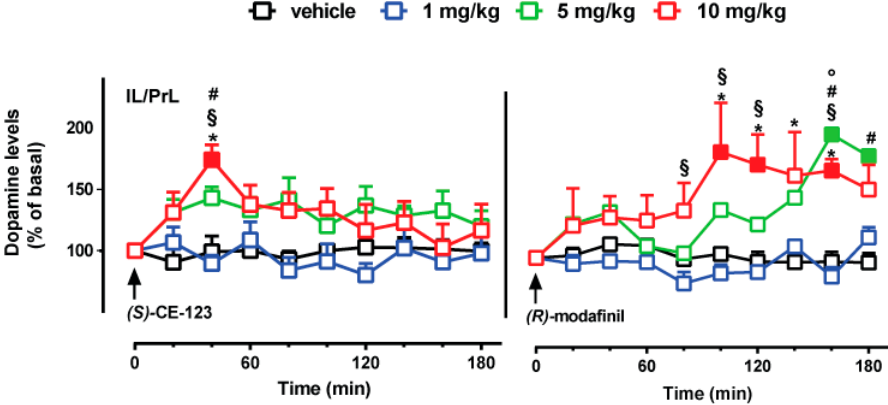
Figure 3. Effect of ( S )-CE-123 and R- modafinil on dopamine transmission in the IL/PrL cortex. Graphs showing the effects of ( S )-CE-123 (left) or R- modafinil (right) on dopamine levels in the IL/PrL cortex. The arrow indicates i.p. injection of ( S )-CE-123 or R- modafinil at the dose of 1 mg/kg (blue), 5 mg/kg (green), 10 mg/kg (red) or vehicle (black). Results are presented as mean ± SEM of change in dopamine extracellular levels expressed as the percentage of basal values. Solid symbol: p < 0.05 with respect to basal values; * p < 0.05 ( S )-CE-123 10 mg/kg vs. vehicle; § p < 0.05 ( S )-CE-123 10 mg/kg vs. ( S )-CE-123 1 mg/kg dose; # p < 0.05 ( S )-CE-123 5 mg/kg vs. veh; ° p < 0.05 R -modafinil 10 mg/kg vs. ( S )-CE-123 10 mg/kg (( S )-CE-123 n = 21; R- modafinil n = 12). Three-way ANOVA, Tukey’s post hoc.